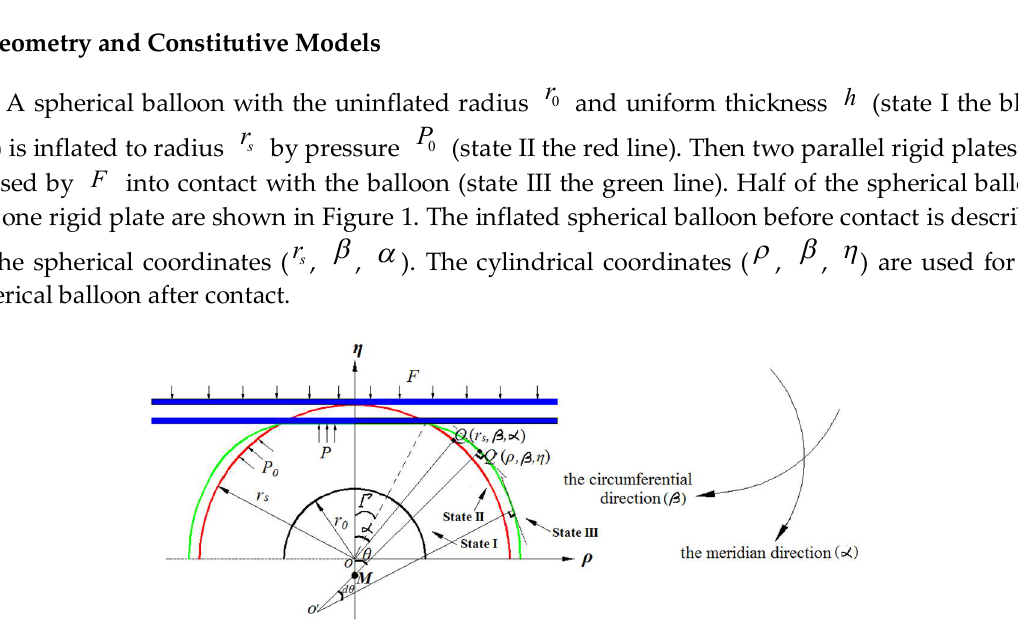
Figure 1. Contact model of an inflated membrane and rigid